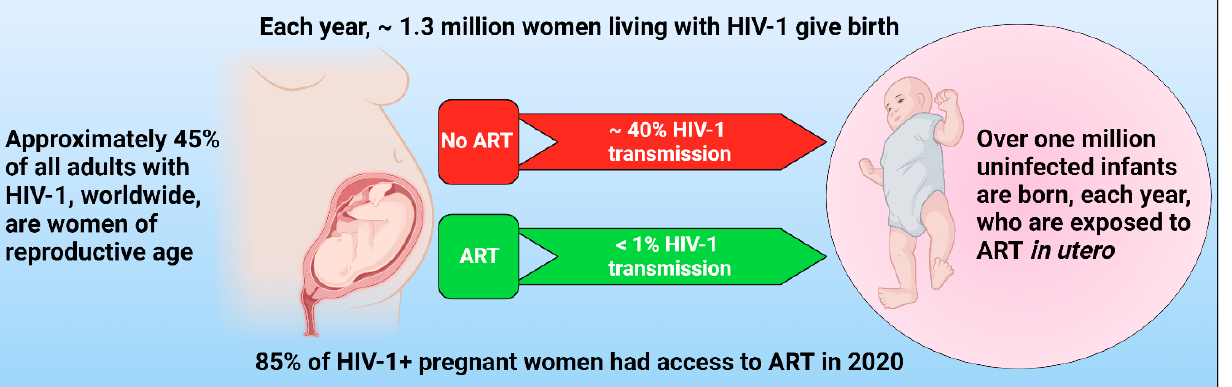
Figure 1. Antiretroviral therapy and mother-to-child HIV-1 transmission. Currently, around 45% of all adults living with HIV-1 infection are women of child-bearing age. Every year, around 1.3 million HIV-1 infected women give birth. Due to increased accessibility of affordable antiretroviral therapy in both resource-rich and resource-limited countries (RRCs and RLCs), vertical transmission rate of HIV-1 infection from mother-to-child has significantly reduced from around 40% to less than 1% with high adherence and accessibility to antiretroviral therapy (ART).